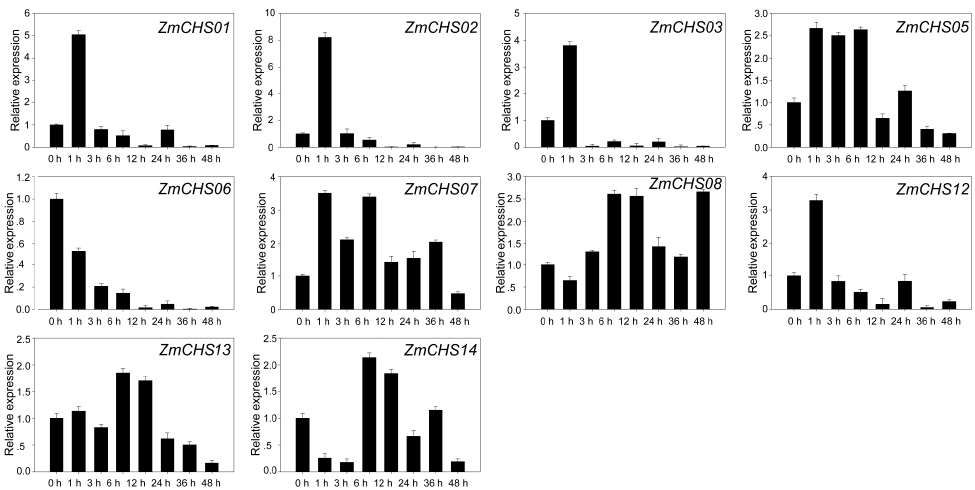
Figure 7. Expression patterns of 10 ZmCHS genes after salicylic acid treatment. Relative expression levels of ZmCHS genes in response to salicylic acid were examined by qPCR and normalized by the expression of Maize Actin 1 (NM_001136991.1). The y -axis represents the relative expression level and the x -axis represents the time course of stress treatment. Seedlings were sampled at 0, 1, 3, 6, 12, 24, 36 and 48 h after salicylic acid treatment. There were three technical replicates for each of the three biological